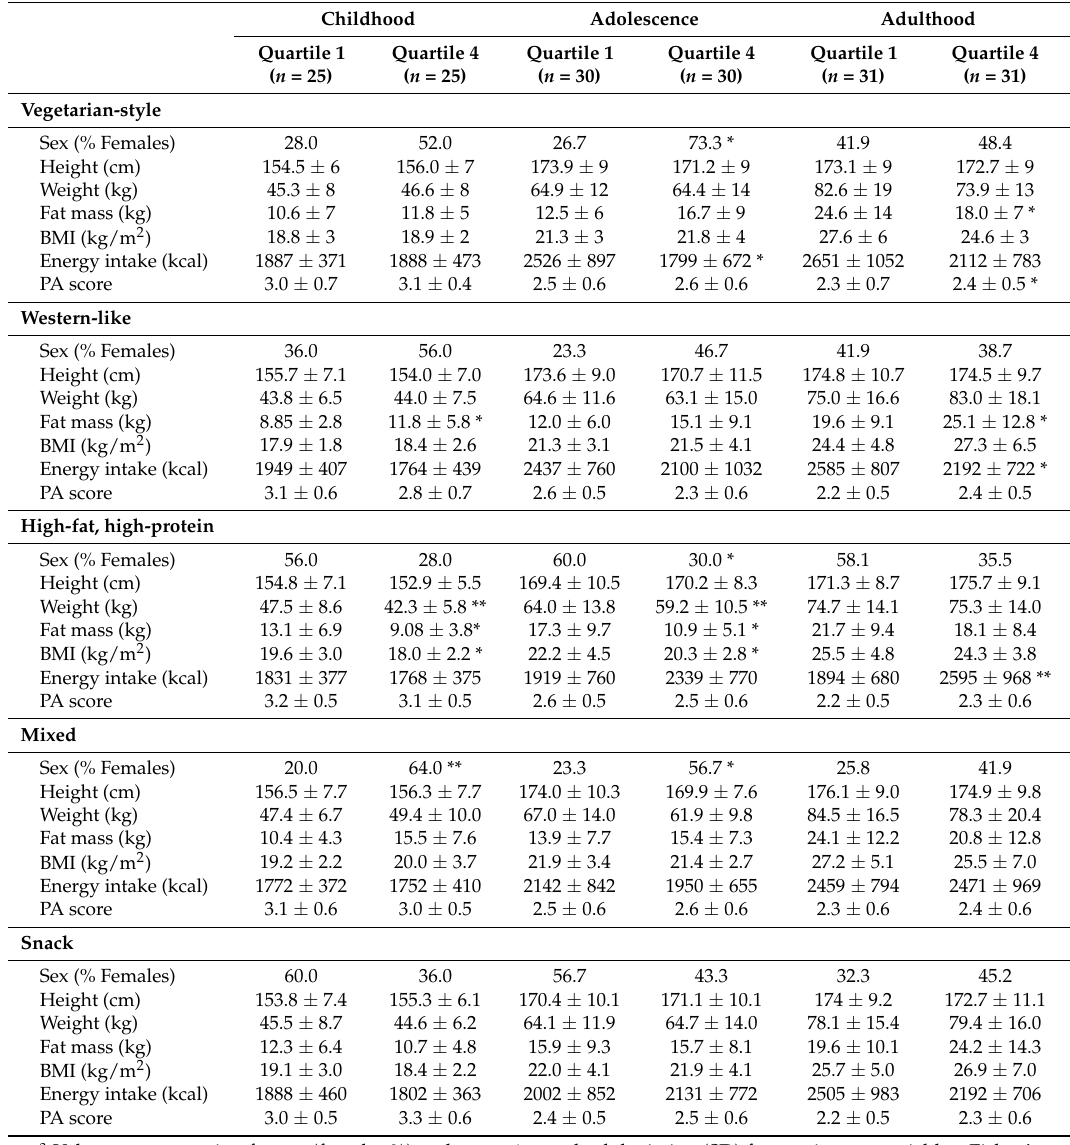
Table 4. Comparing characteristics of participants across two extreme quartiles for each dietary pattern score during childhood, adolescence, and adulthood a